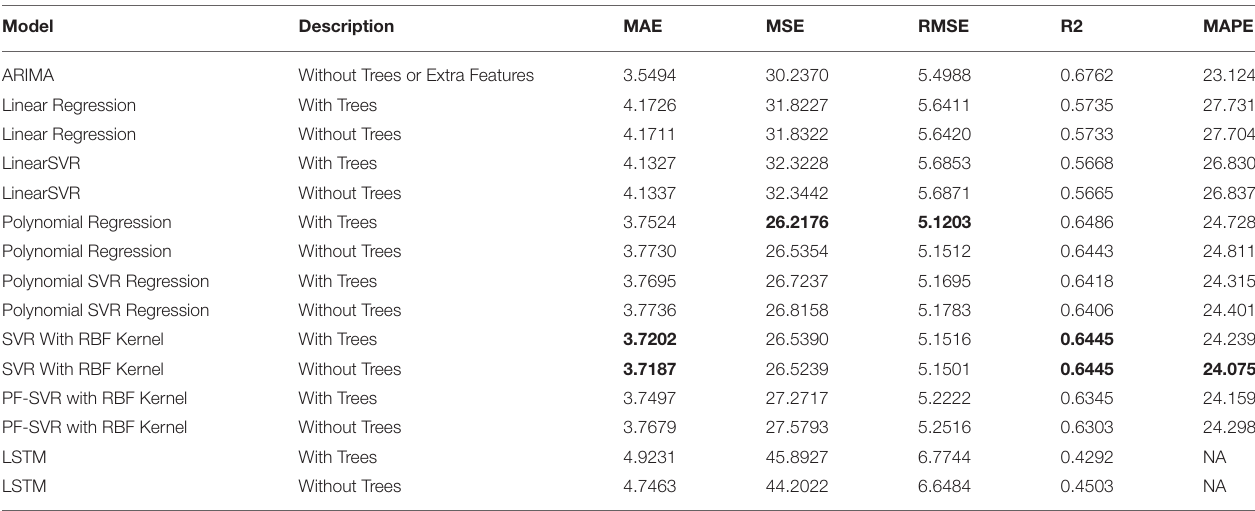
TABLE 9 | Experimental results for PM10, location-2, Gonville